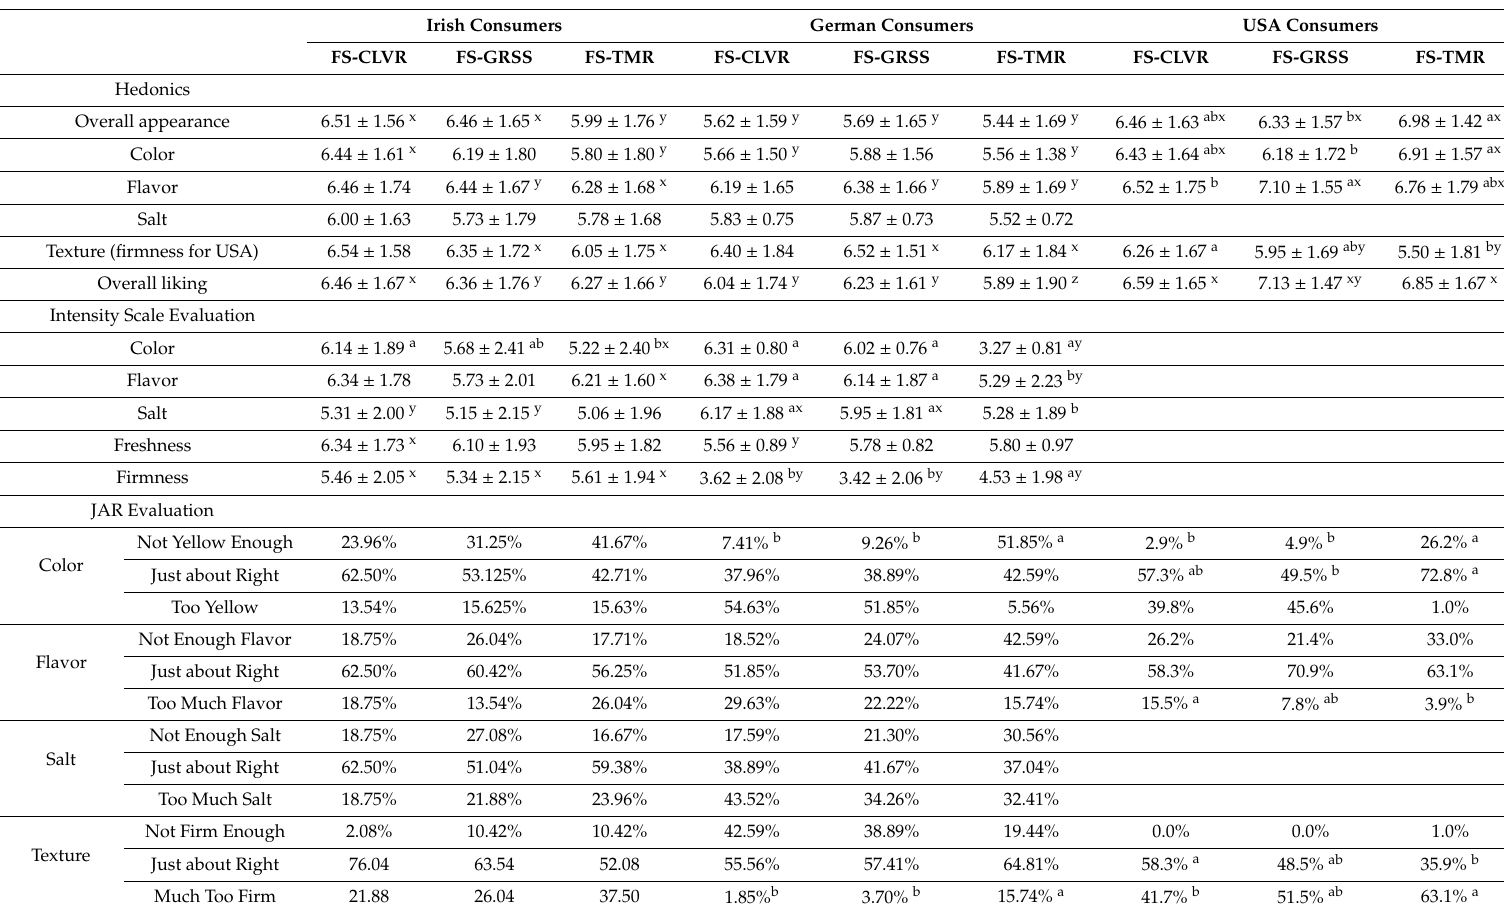
Table 1. Cross-cultural comparison of liking, intensity rating and just-about-right scale evaluation by Irish, German and United States of America consumers, of butters produced by di ff erent diets—FS-GRSS, FS-CLVR and